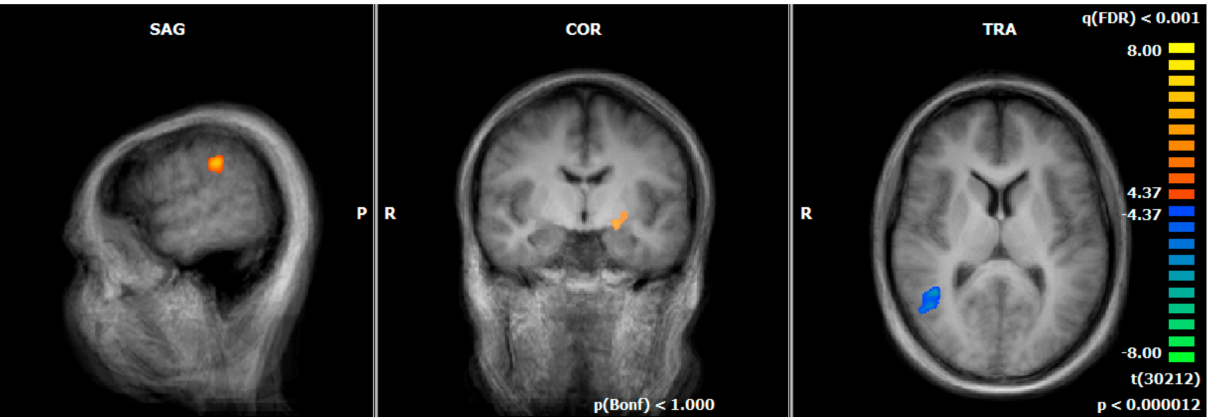
Figure 5. Hemodynamic responses of the first vs. the last NF run: MDD REAL vs. HC REAL (negative emotional pictures > neutral pictures; q (FDR) < 0.001, T-score: − 8 to 8, fixed-effects-analysis); in blue, increased hemodynamic responses of the HC REAL group compared to MDD REAL, e.g., in middle temporal gyrus; in orange, increased hemodynamic activations of MDD REAL compared to HC REAL, e.g., supramarginal gyrus and lateral globus pallidus/amygdala (x = 57; y = − 8; z = 10). A = anterior, P = posterior, R =